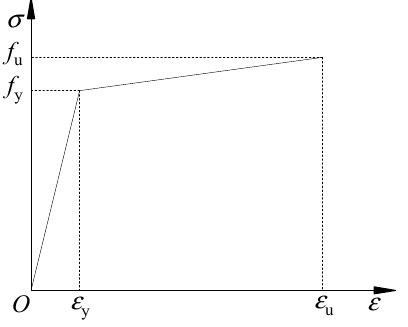
Figure 12. The stress-strain relationship of steel. Table 9. Bifold model parameters of steel.